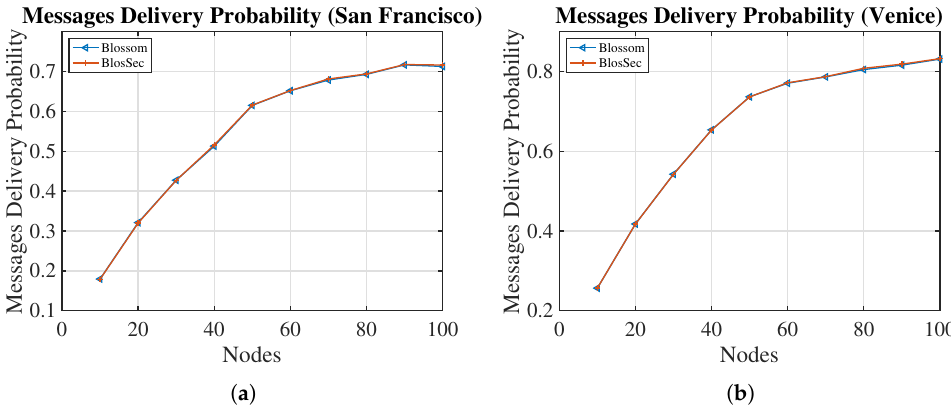
Figure 8. Comparison of Blossom against BlosSec in terms of message delivery probability. ( a ) San Francisco; ( b ) Venice.